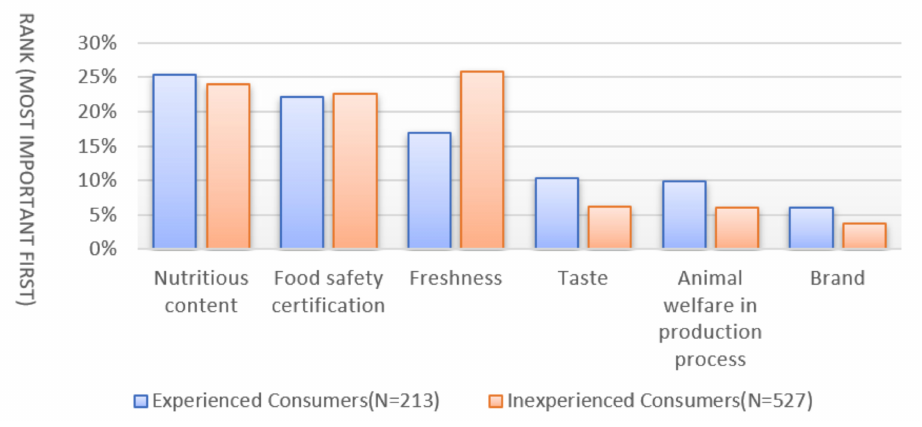
Figure 4. Consumers perceived importance of egg